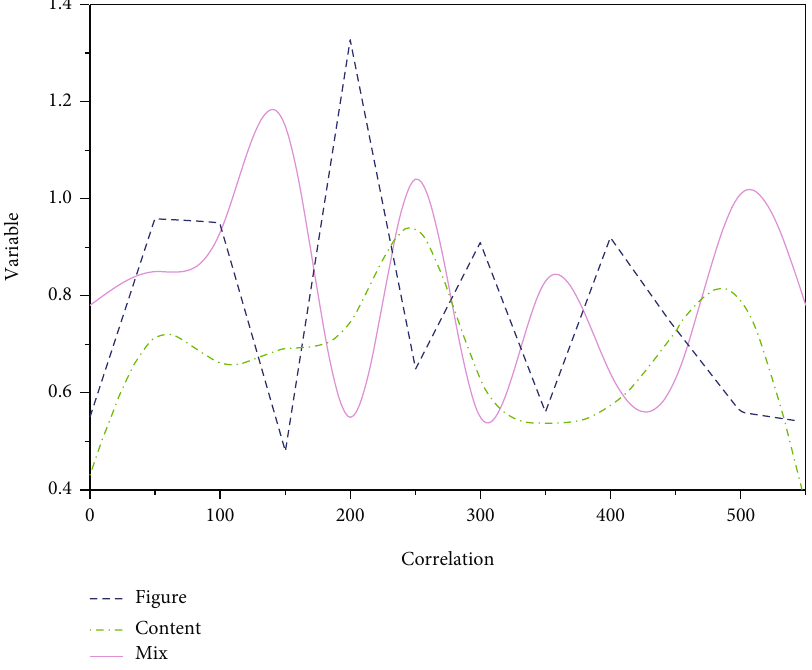
Figure 2: Schematic diagram of the Pearson correlation coe ffi Table 3: Features used by di ff erent models and their weights. Features